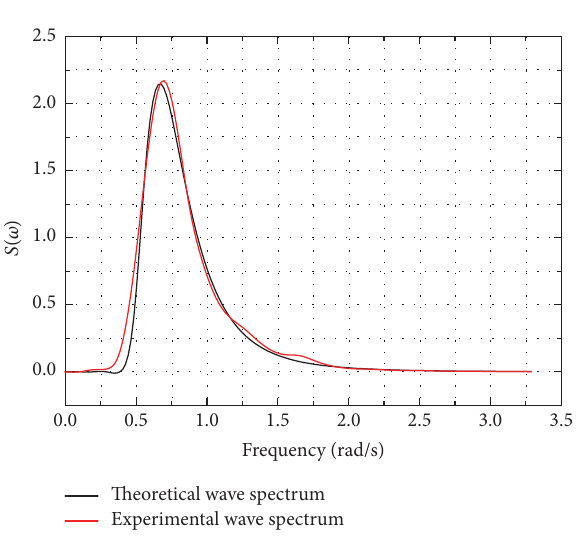
Figure 10: Comparison of wave spectral